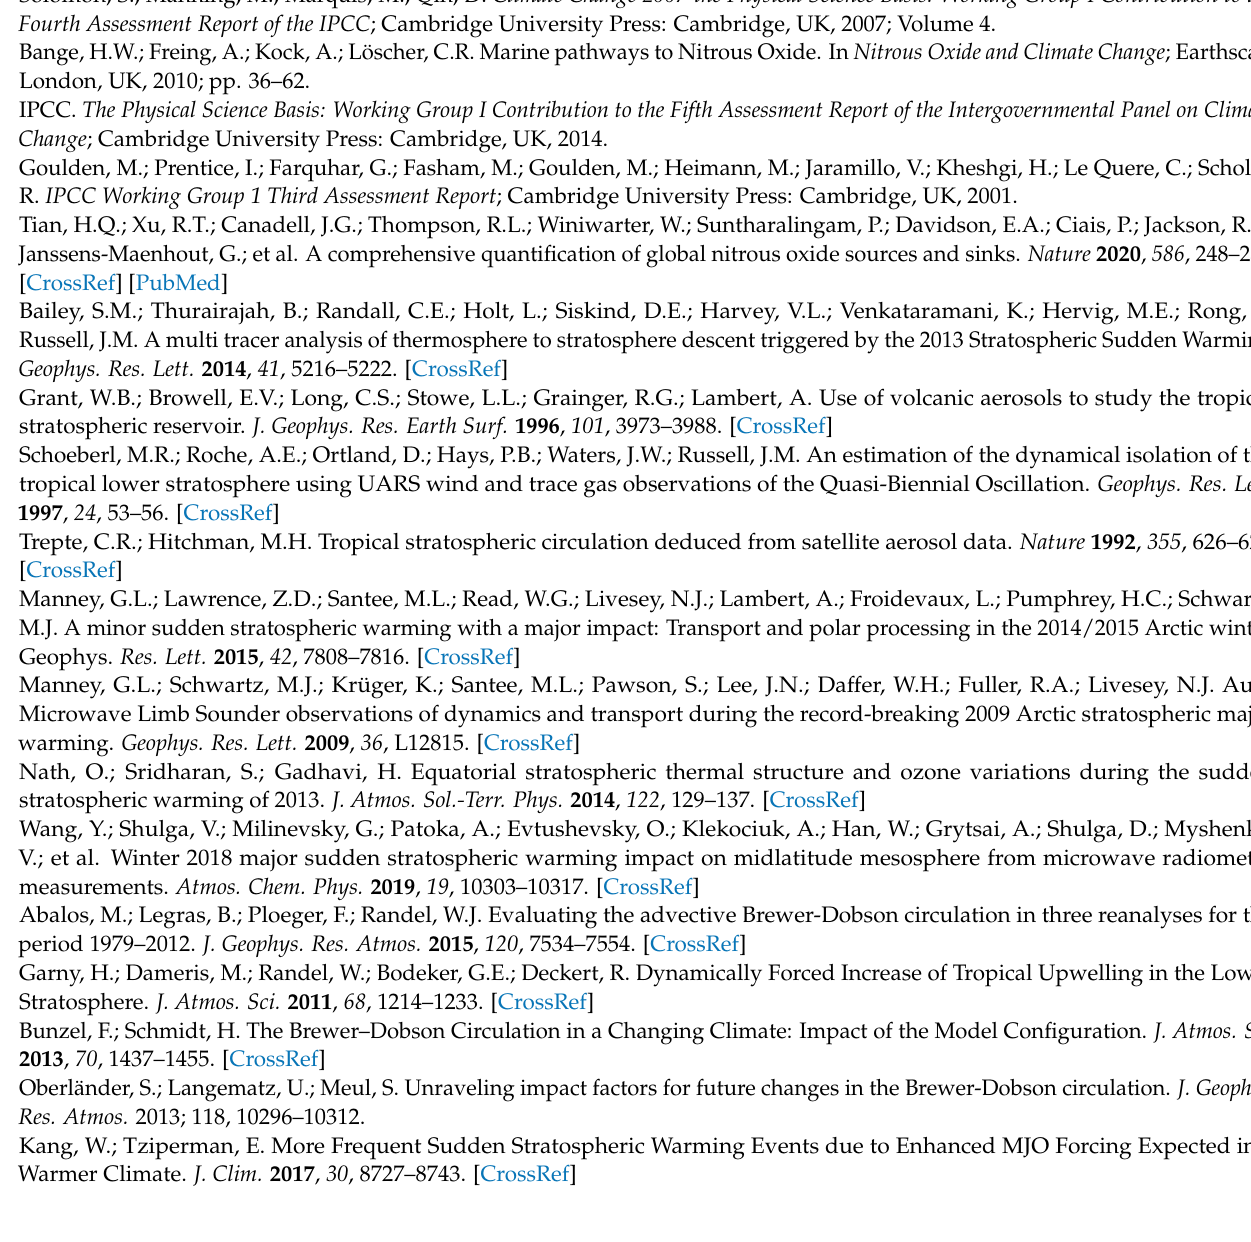
Figure A3. ( a ): Annual average tropical upward mass flux at 70 hPa; ( b ) mean residual vertical velocities w ∗ at 70 hPa from ERA5 for 2005 – 2020.